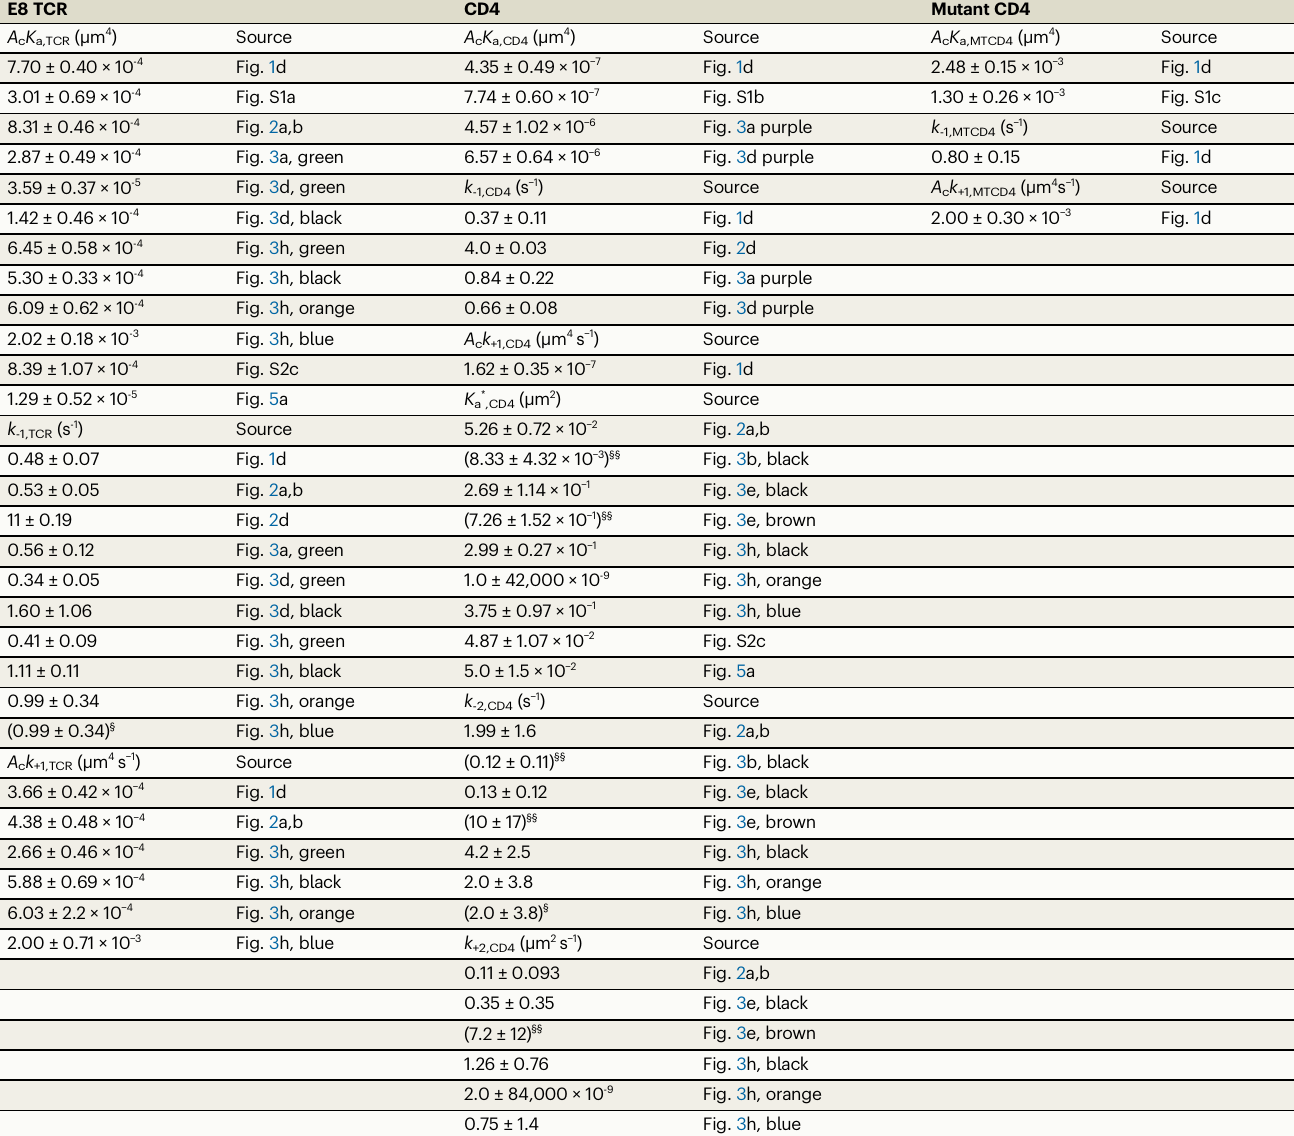
Figure2d:BFP thermal fl uctuation assay with fi tting toln( p )= − k off t . Figure3a,b,d,e:BFP adhesion frequency assay with thesingle-speciesdata fi tting to Eq. 8 and dual-species data fi tting toEqs. 1 and 2. Figure3e,brown:BFPadhesionfrequencyassaywiththeblackdata fi ttingtoEqs.1and2usingonlytwoparameters( K a * ,CD4 and k -2,CD4 )after fi xing A c K a,TCR and k − 1,TCR atvaluesobtainedfrom fi tting thegreenandpurple data byEq. 8. Figure3h:Micropipetteadhesionfrequencyassaywith fi ttingtoEq.8(greencurve)andEqs.1and2(greenandblackcurves,orangecurve,andbluecurvewith k − 1,TCR and k − 2,CD4 fi xedatthevalues obtainedfrom fi tting theorange curve). Figure5a: Micropipetteadhesion frequency assaywith fi ttingtoEq. 4. at steady-state. Fig. S1a – c: Micropipette adhesion frequency assay with fi tting toEq. 7 at steady-state. Fig. S2c:Micropipetteadhesion frequency assaywith fi ttingtoEq. 3. at